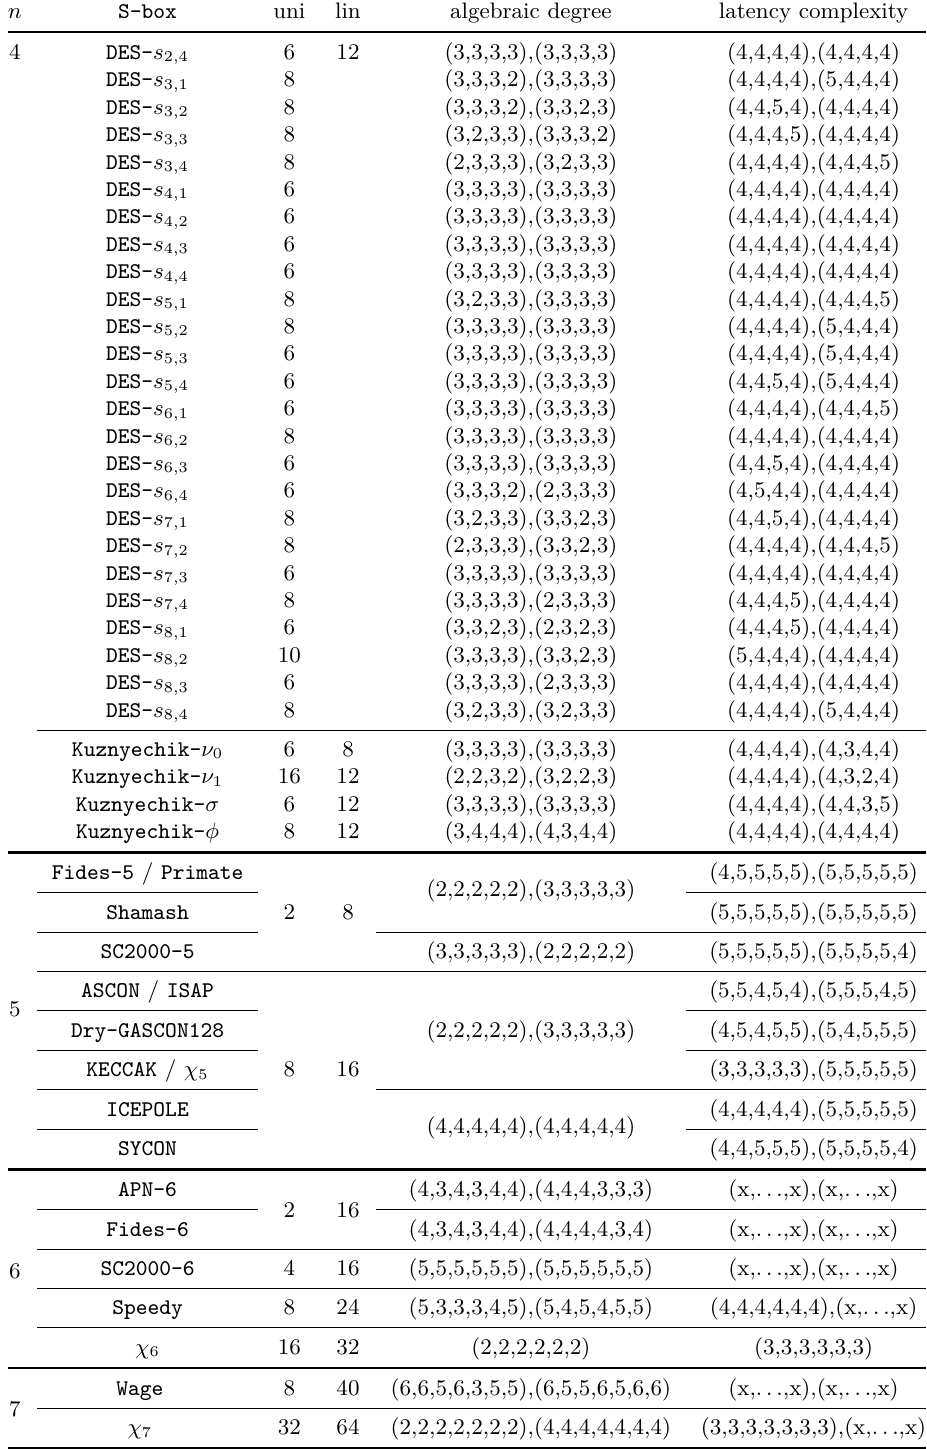
Table 7: Latency Complexity of Known S-boxes